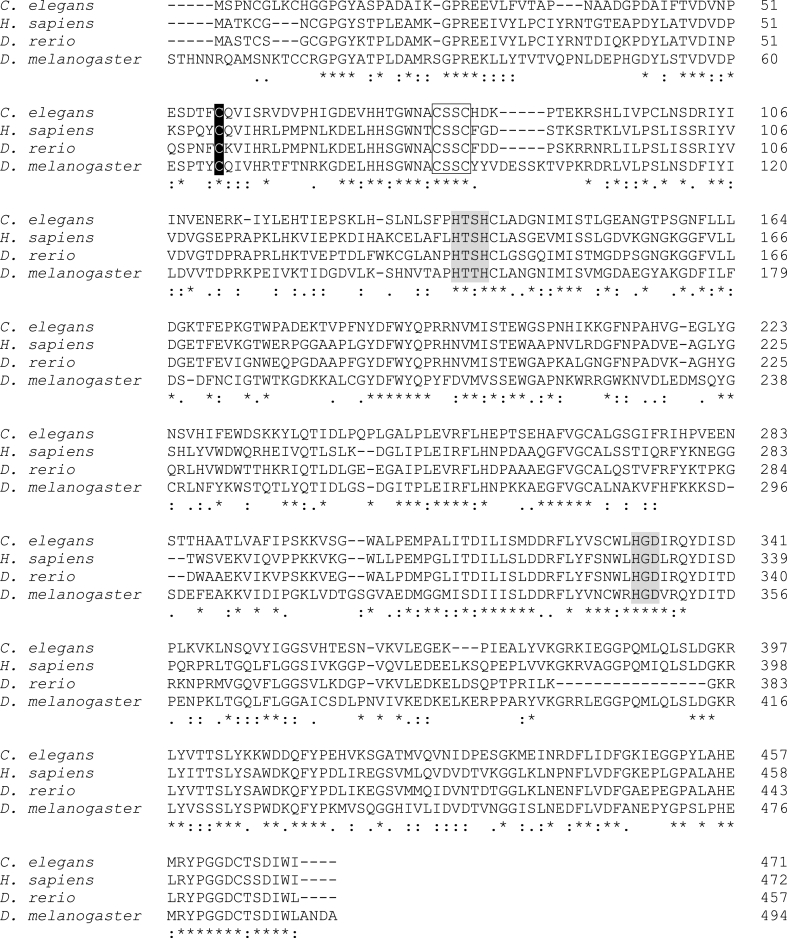
Y37A1B.5 displays high sequence homology with SELENBP1. Alignment of C. elegans Y37A1B.5 (NCBI Ref Seq#: NP_001255777.1) with human SELENBP1 (GenBank accession#: CAG33133.1) and orthologs from Danio rerio (NCBI Ref Seq#: NP_956864.1) and Drosophila melanogaster (LP16180p; GenBank accession#: AAV36940.1). The alignment identifies 52% identical aminoacyl residues for SELENBP1 and Y37A1B.5. Asterisk (*): fully conserved residue; colon (:): conservation between groups of strongly similar properties, Gonnet PAM 250 matrix > 0.5; period (.): conservation of weakly similar properties between groups, Gonnet PAM 250 matrix < 0.5. Multiple sequence alignment was performed using CLUSTAL O (1.2.4) [43]. Selected conserved motifs are highlighted as follows: Cys57, highlighted in black; thioredoxin motif (CxxC, transparent box); histidine-containing metal binding motifs (HxD, HxxH, gray background); see text for details.